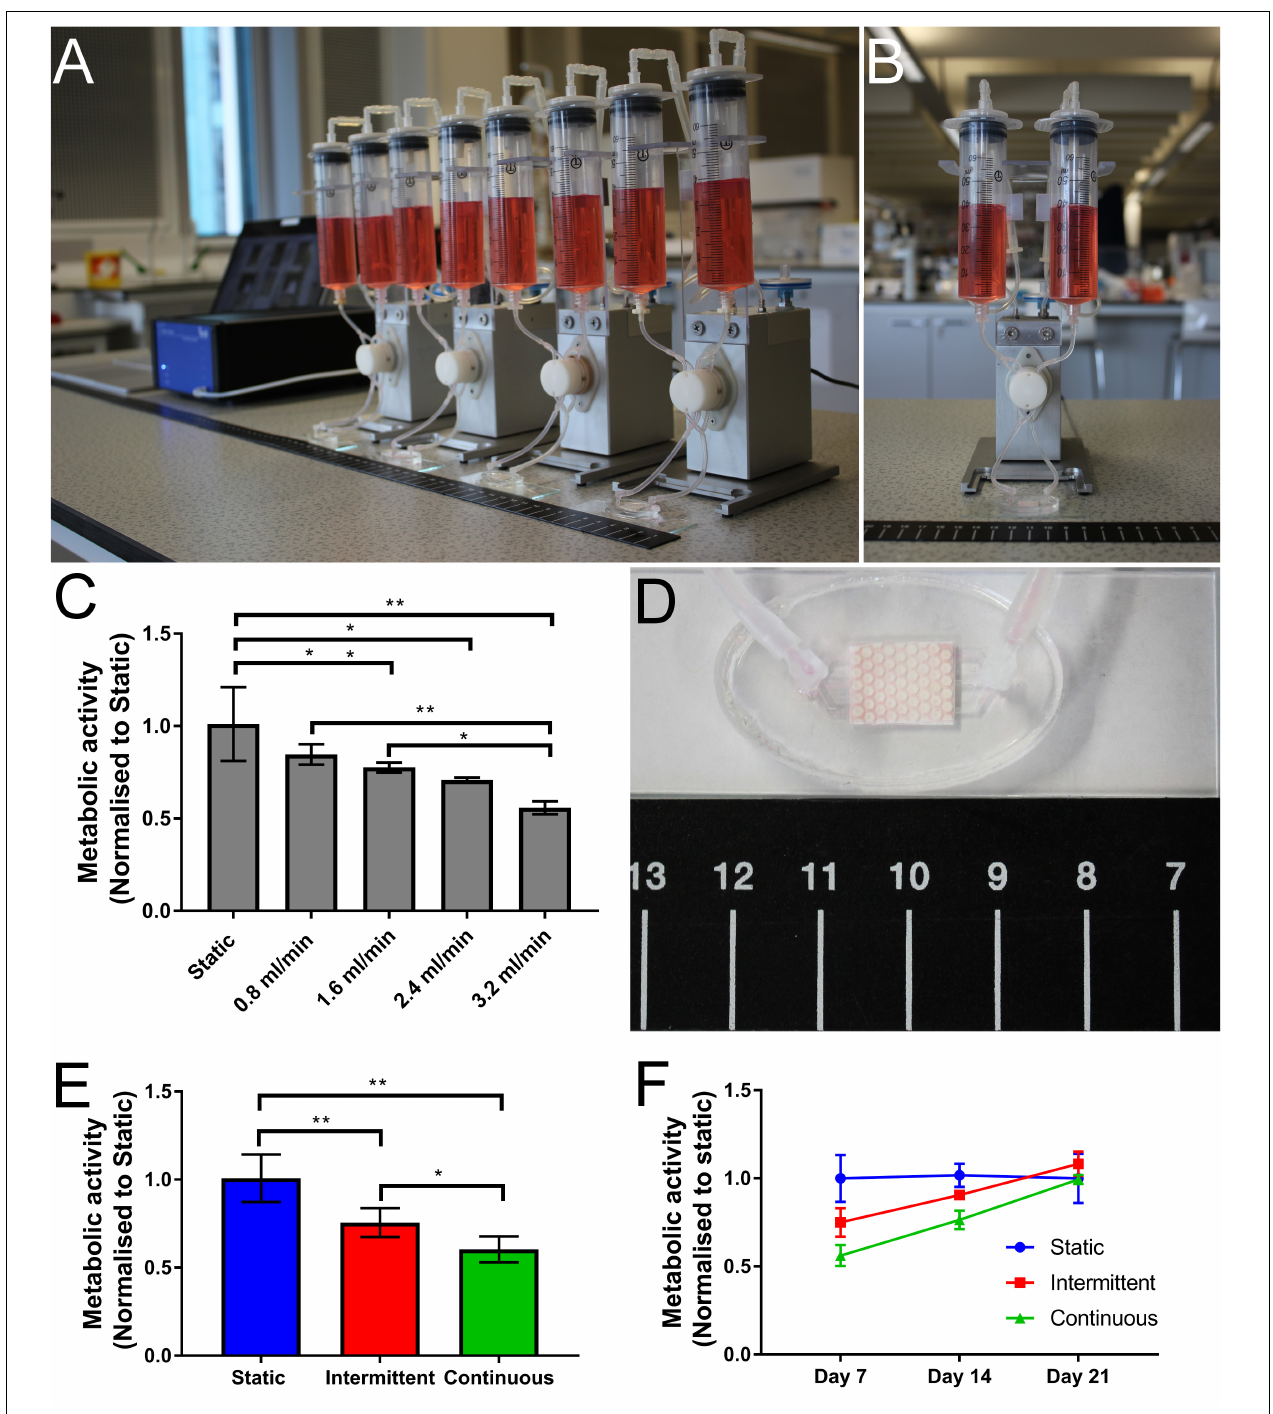
FIGURE 3 | Photographs of (A) the Ibidi fluidic system and (B) a single fluidic unit. (C) Cell metabolic activity on day 7 normalized to static control for four different flow rates (0.8, 1.6, 2.4, and 3.2 mL/min). As flow rate increases, metabolic activity decreases (* p < 0.05, ** p < 0.01) ( n = 4). (D) Photograph showing a perfused bone microfluidic chip connected to the commercial Ibidi perfusion pump system with ruler for scale. (E,F) Comparison of metabolic activity over time with different flow profiles. (E) Day 7 metabolic activity. Both the intermittent (0.8–3.2 mL/min) and continuous (3.2 mL/min) flow profiles have significantly lower metabolic activity after 1 week than the static control, although the intermittent is significantly higher than the continuous. (F) By day 21 the cell metabolic activity has recovered for both intermittent and continuous flow profiles, resulting in no significant difference. Recovery is achieved sooner in the intermittent condition ( n = 8) (* p < 0.05, ** p <